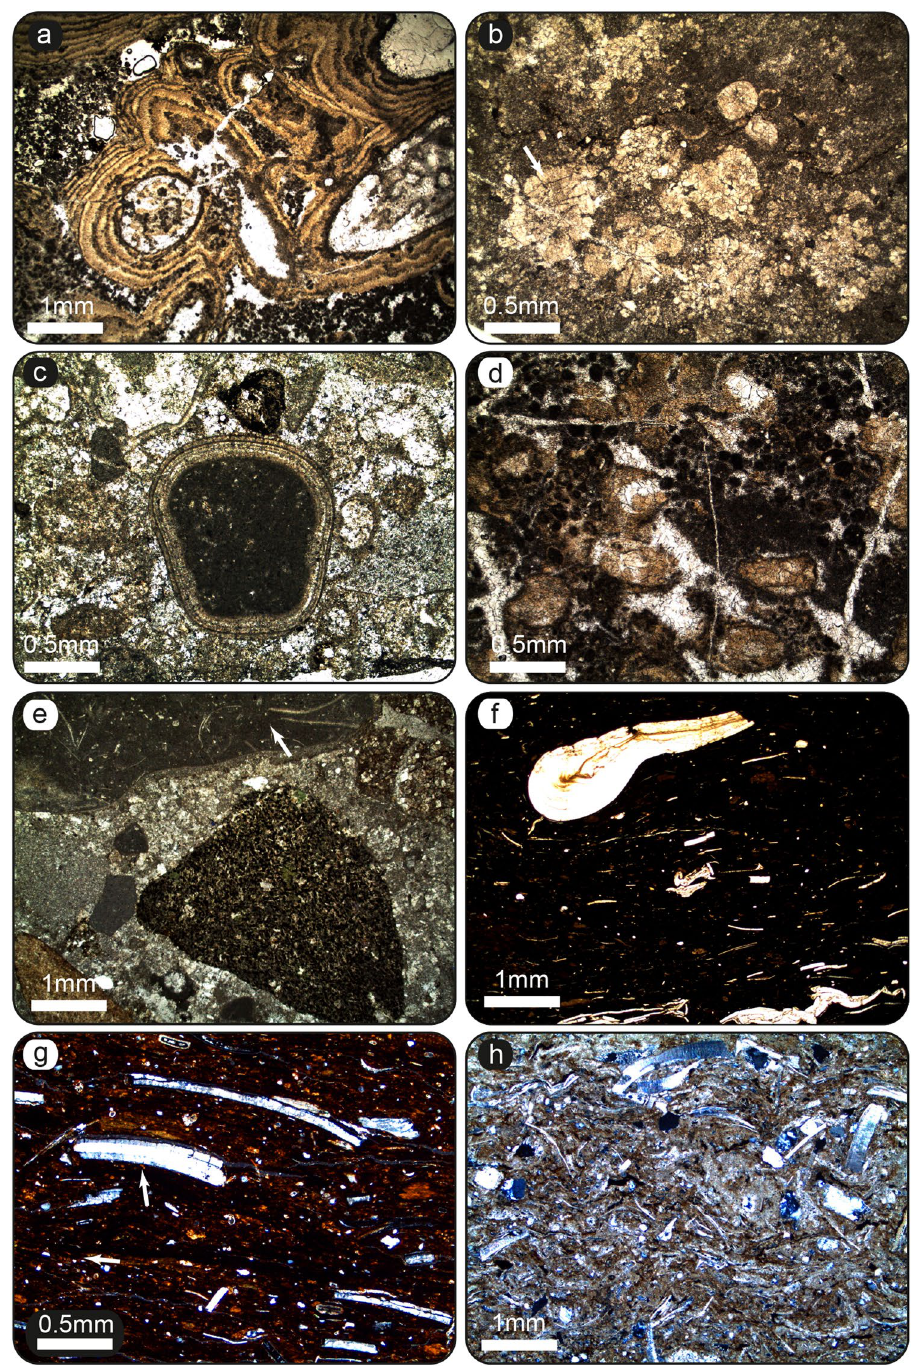
Figure 4. Palustrine-lacustrine microfacies of the Jiuziyan Fm. ( a – d ) and Shuanghe Fm. ( e – h ). See Fig. 2 for location of sites. ( a ) Microbial deposits encrusting calcified macrophyte stems (facies Phs). The coating consists of an alternation of light and dark laminae as in stromatolites. Note the micropeloidal matrix filled with microspar cement (Sample J194, site S596). This facies typifies primary palustrine-lacustrine deposits before undergoing pedogenesis. ( b ) Pedogenic features (caliche, facies Cal). Calcified root structures in cross section made of individual calcified root cells, creating typical Microcodium structure (arrow) (Sample J225, site S254). ( c ) Granular limestone (facies Lgr) composed of both intraclasts and extraclasts within interstitial microspar cement. Note the large oncoid consisting of a Paleozoic/Mesozoic nucleus (carbonate extraclast) and a sub-mm cortice made of alternating calcite spar to microspar laminae (Sample J158g, site S254). ( d ) Nodular micropeloidal and intraclastic limestones. Note the presence of caliches such as circumgranular dessication cracks, filled with microspar cement (Sample J194b, site S596). ( e ) Granular limestone including extraclasts (marine Paleozoic/Mesozoic packestone – arrow, and igneous rock fragments) filled by microspar